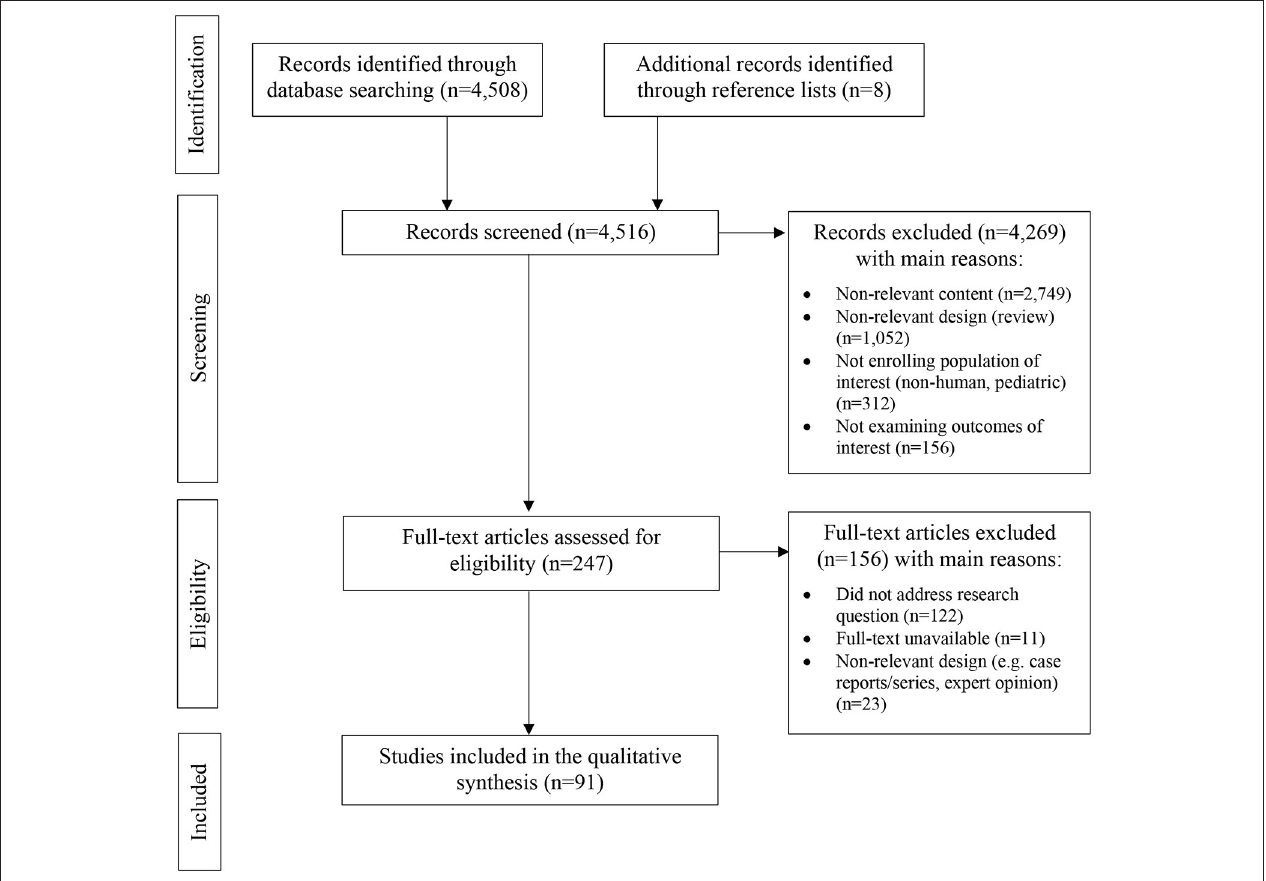
FIGURE 1 | PRISMA flow diagram demonstrating included and excluded studies, and the reasons for exclusion in the systematic